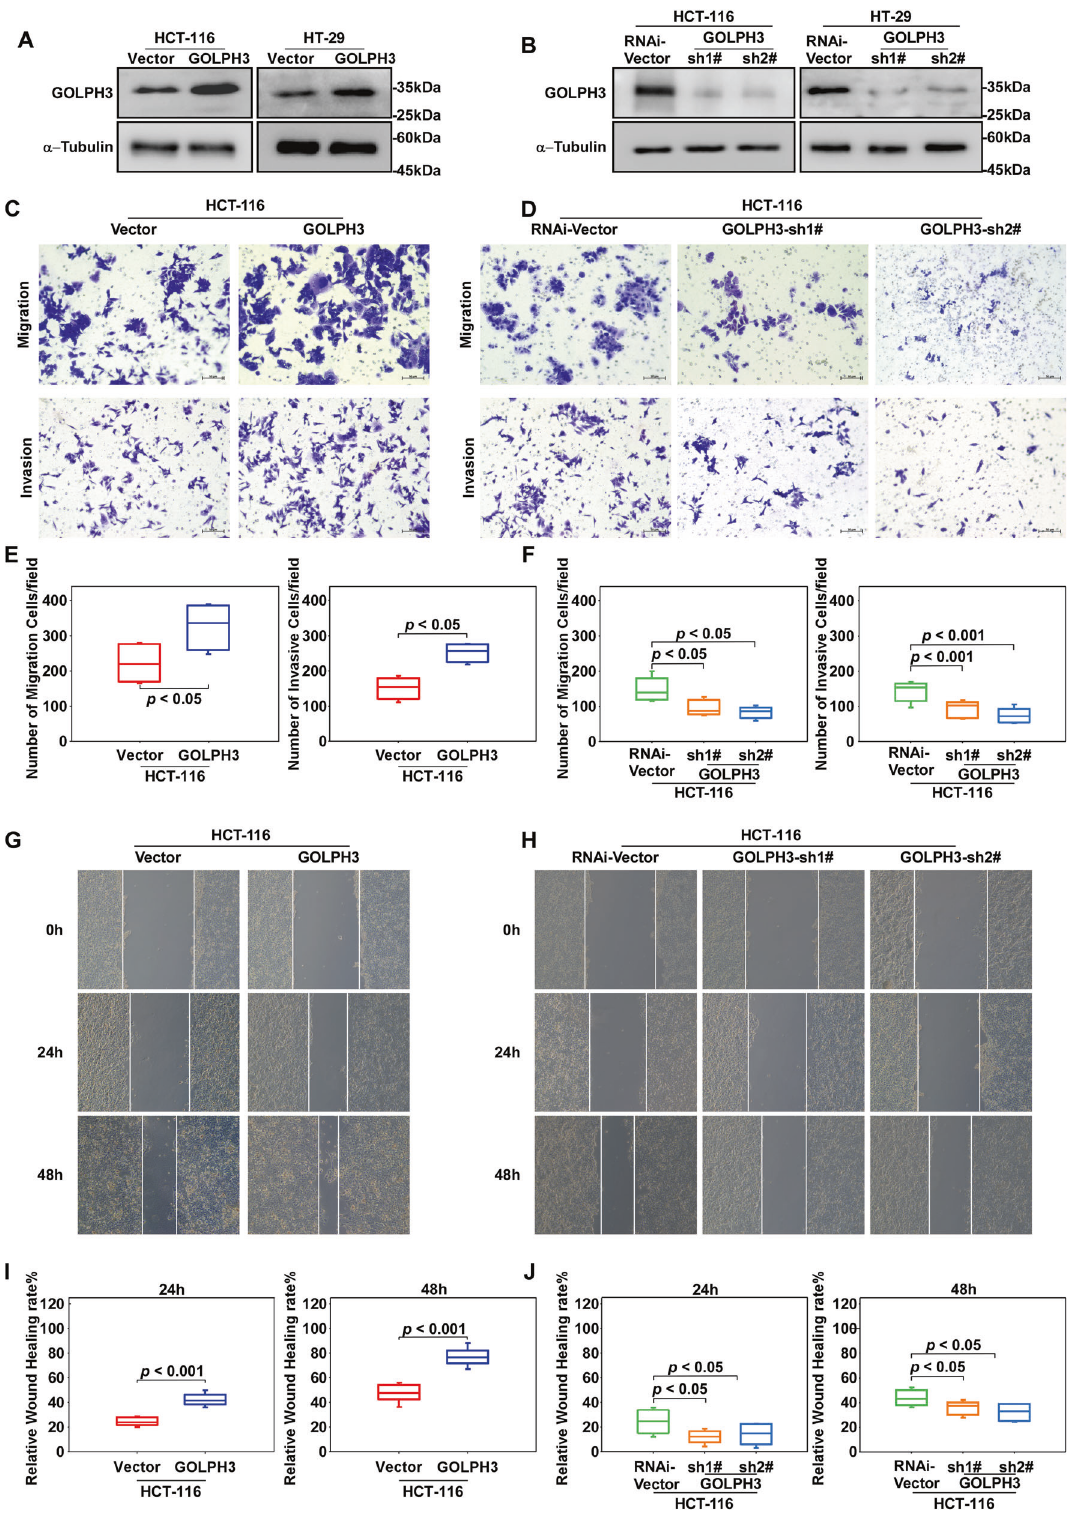
During the process of autophagy, autophagosomes engulf cytoplasmic components. p62 is an autophagy adapter protein that binds to ubiquitylated protein aggregates and delivers them to autophagosomes. The level of p62 in cells is inversely proportional to the extent of autophagy. The LC3 family is a Cell Death Discovery (2022)